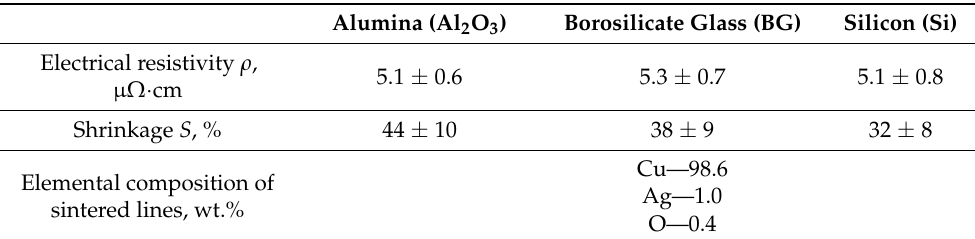
Table 3. Electrical resistivity, shrinkage, and elemental composition of sintered lines made of spherical copper-based nanoparticles.